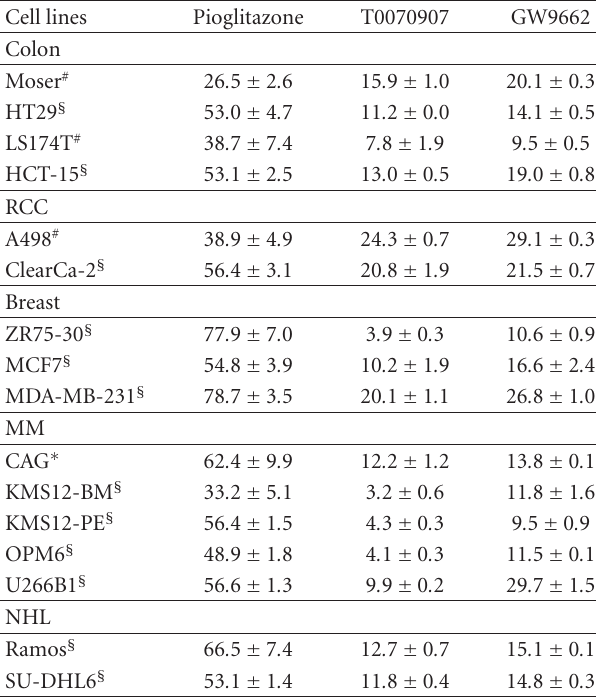
Table 1: Mean IC 50 values ( μ M) for the PPAR γ